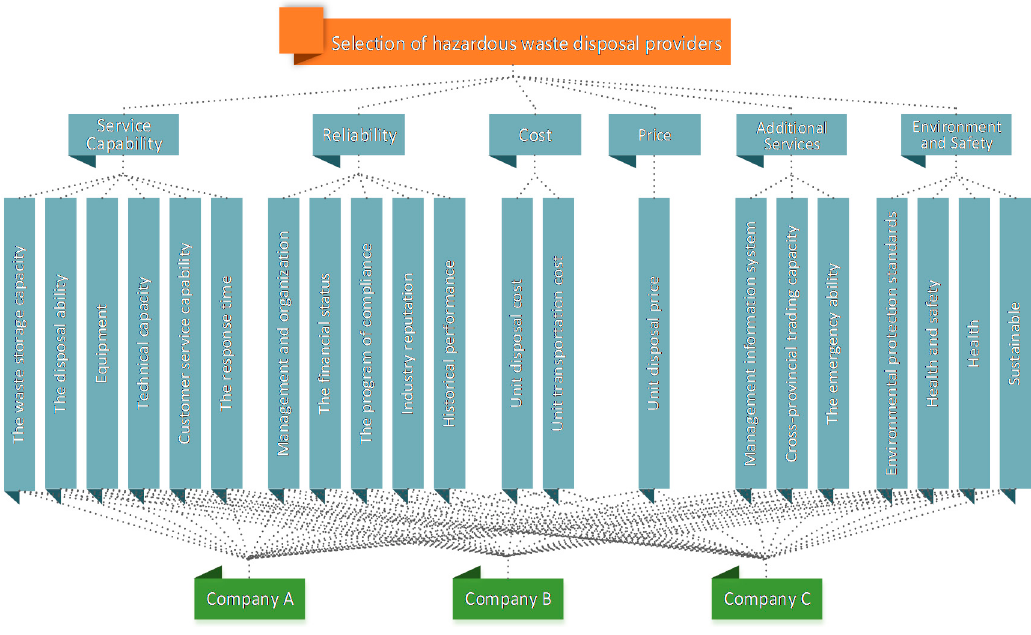
Figure 3. Hierarchical structure for hazardous waste disposal enterprise selection.